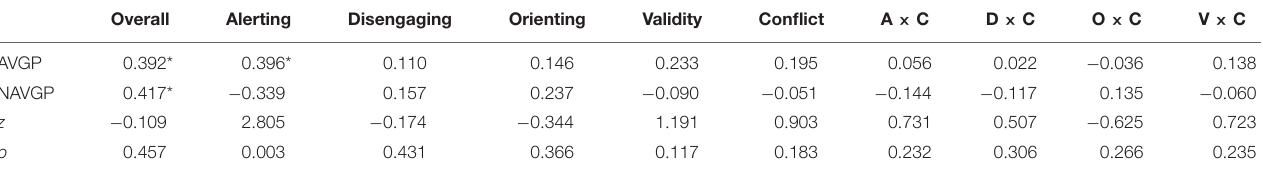
TABLE 8 | Correlation coefficients for the attentional effects in different groups between the ANT-V and the ANT-A. Overall Alerting Disengaging Orienting Validity Conflict A × C D × C O ×